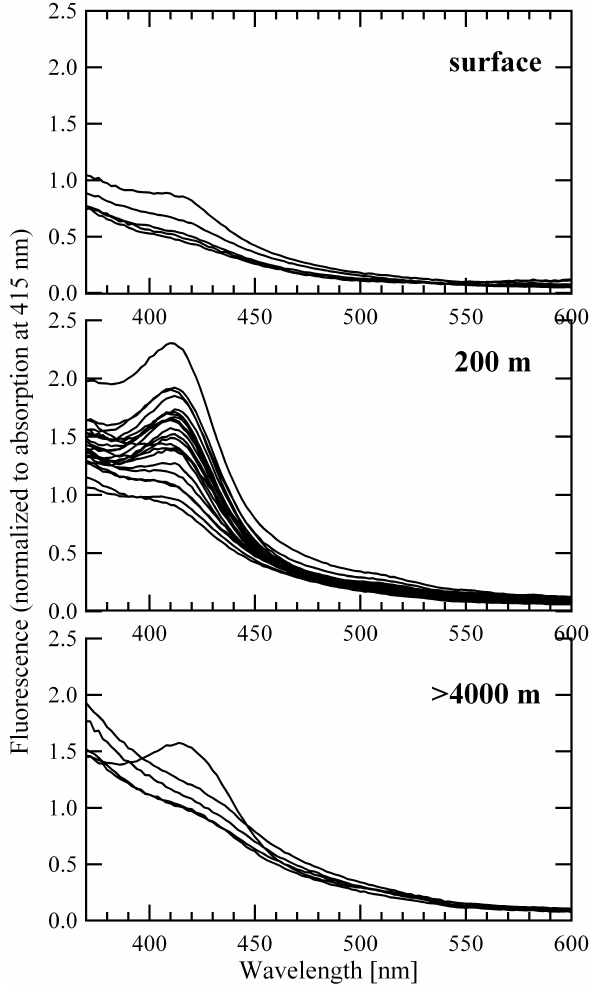
Fig. 10. Excitation spectra for the 650-nm emission maxima for samples taken in the eastern Atlantic Ocean during ANT-XXV/1 at (a) the surface, (b) 200m depth, (c) depths of >